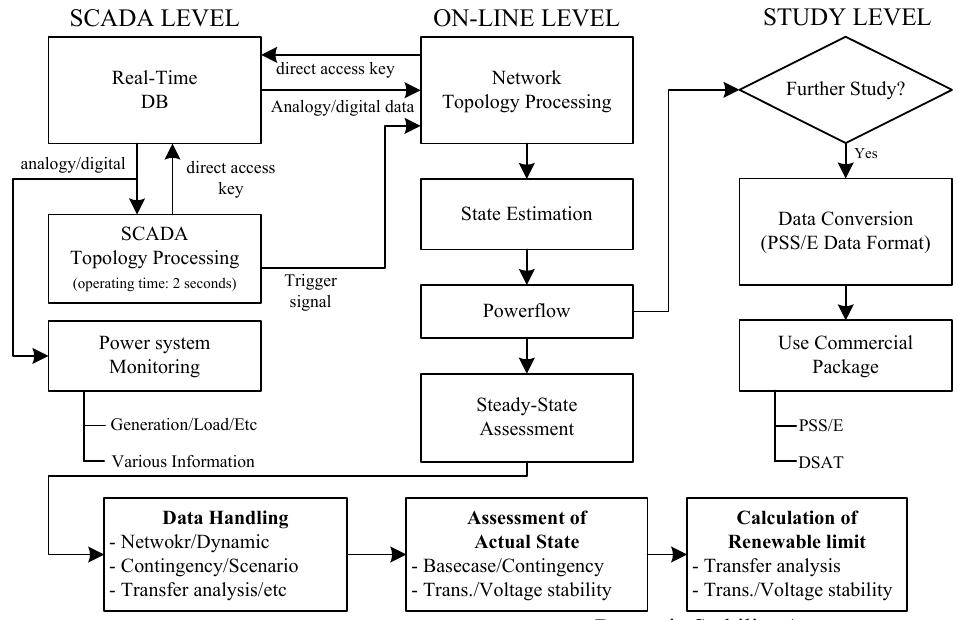
Figure 3. Network analysis structure in the REMS.